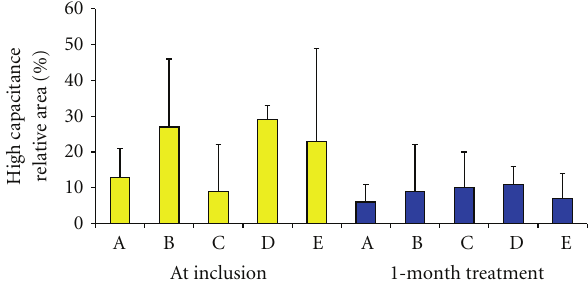
Figure 2: Relative area (means ± SD) of the PCM darker pixels in 5 psoriatic lesions from 5 patients (A to E) at inclusion and after a 1-month ustekinumab treatment. The global reduction in high capacitance inflammatory areas is significant ( P < 0 .